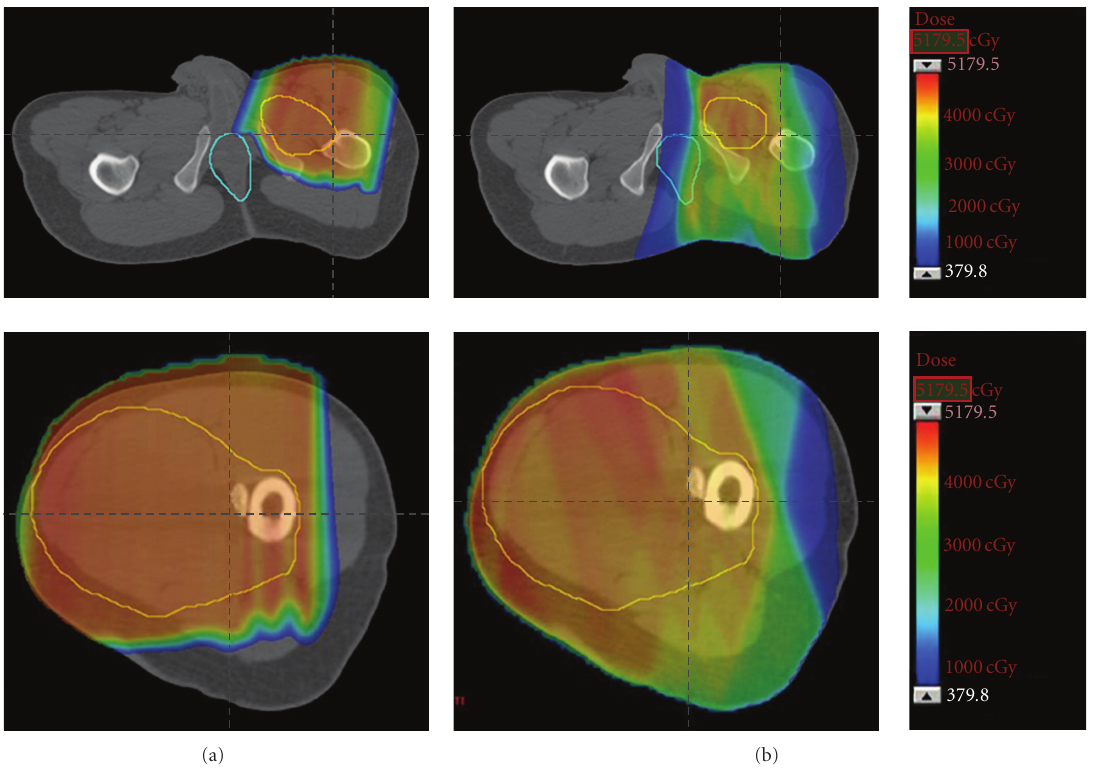
Figure 2: Comparison of preoperative proton (a) and photon (b) dosimetry for soft tissue sarcoma of the thigh shown in Figure 1. The tumor target volume is outlined in yellow and the anus is outlined in aqua blue. Note how the proton plan spares the perineal region and lymphatic drainage of uninvolved soft